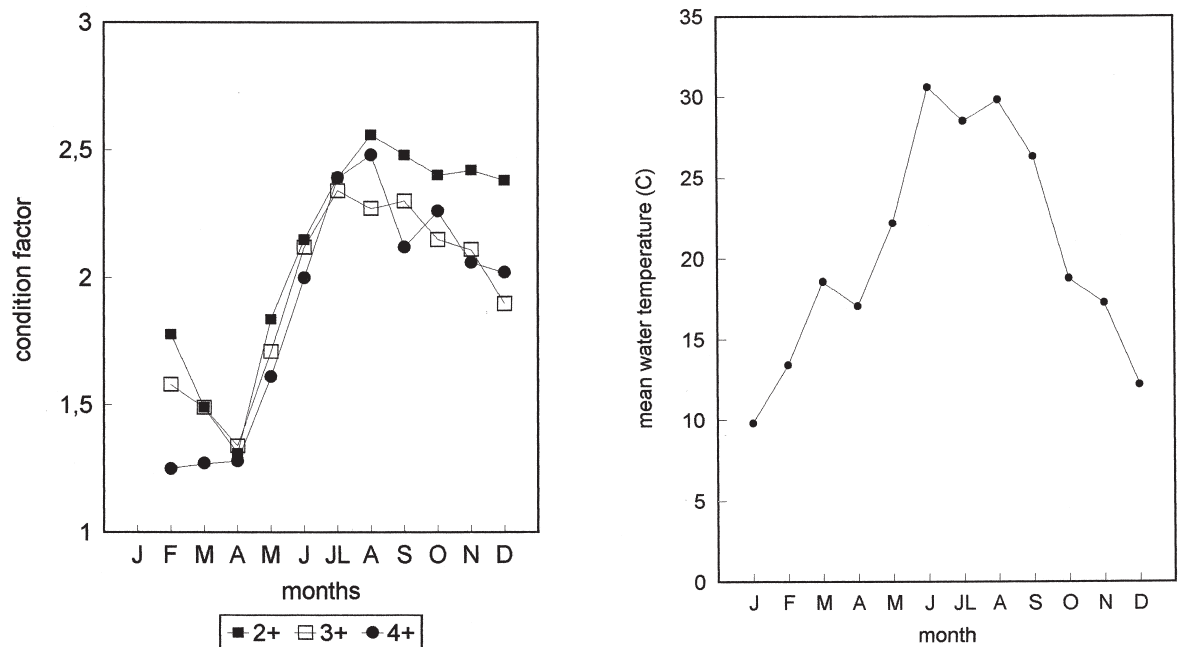
F IG . 5. – Monthly profile of average condition factor of three age- classes of Liza saliens from the Albufera des Grau lagoon